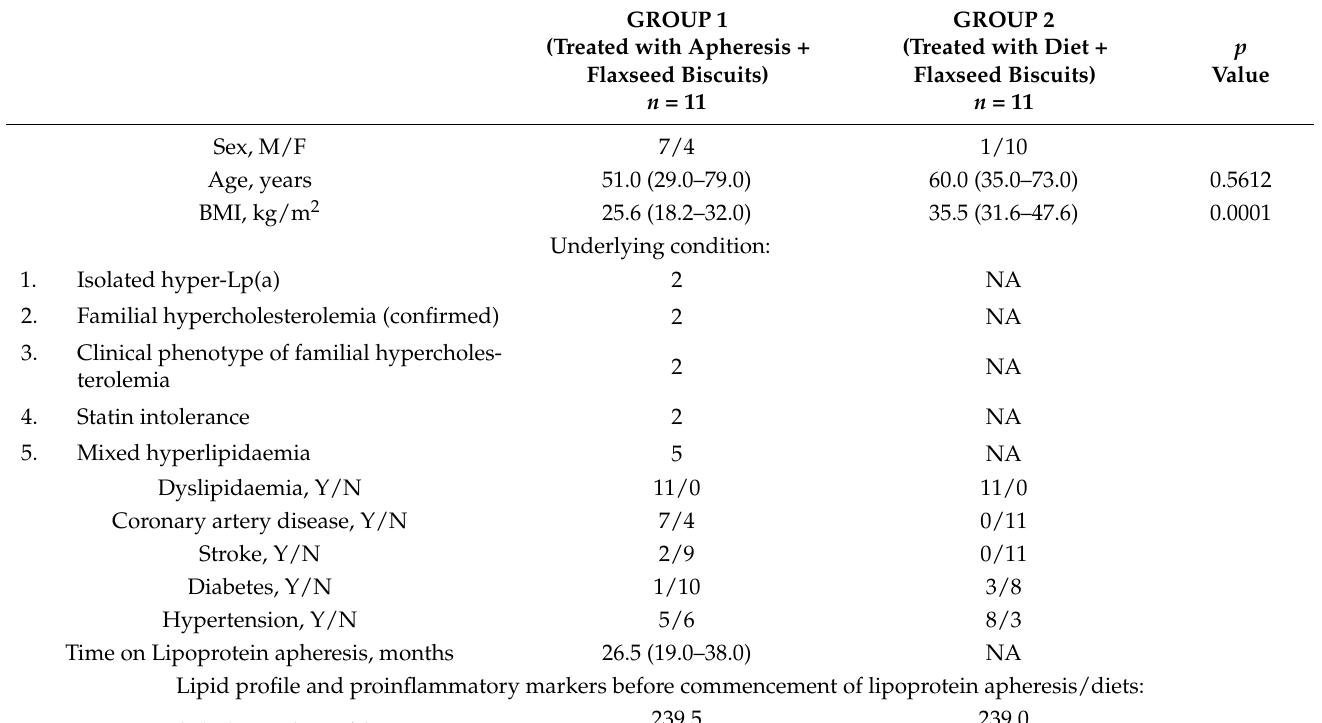
Table 1. Baseline characteristics of the participants. The data are given as medians and range, n =